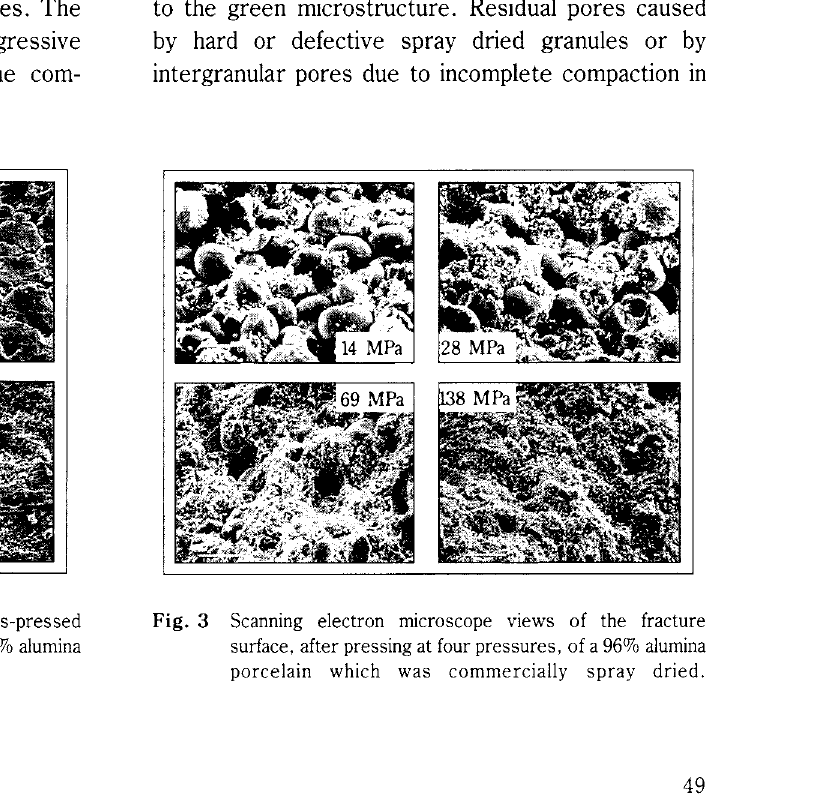
Fig. 2 Scanning electron microscope views of the as-pressed surface after pressing at four pressures, of a 96% alumina porcelain which was commercially spray dried.